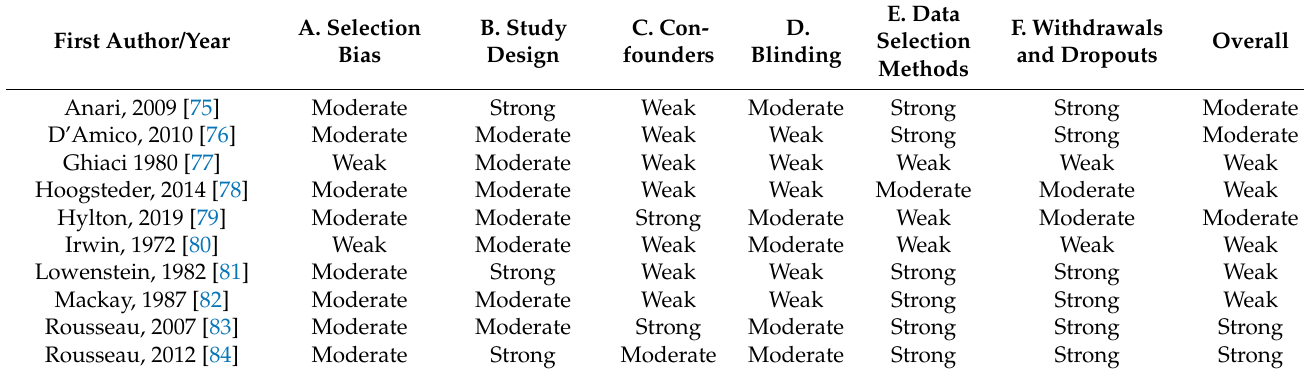
Table 4. Quality of the